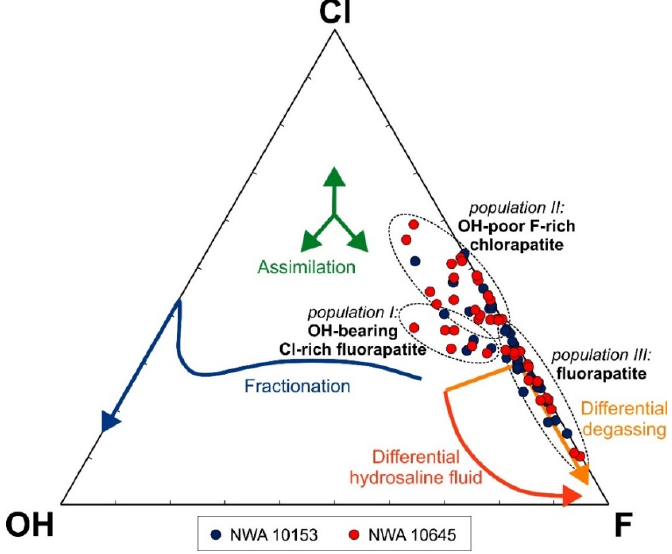
Figure 2. Ternary plot of the apatite X-site occupancy (mol %) for NWA 10153 and NWA 10645 with marked evolutionary trends (after McCubbin et al. [50]).